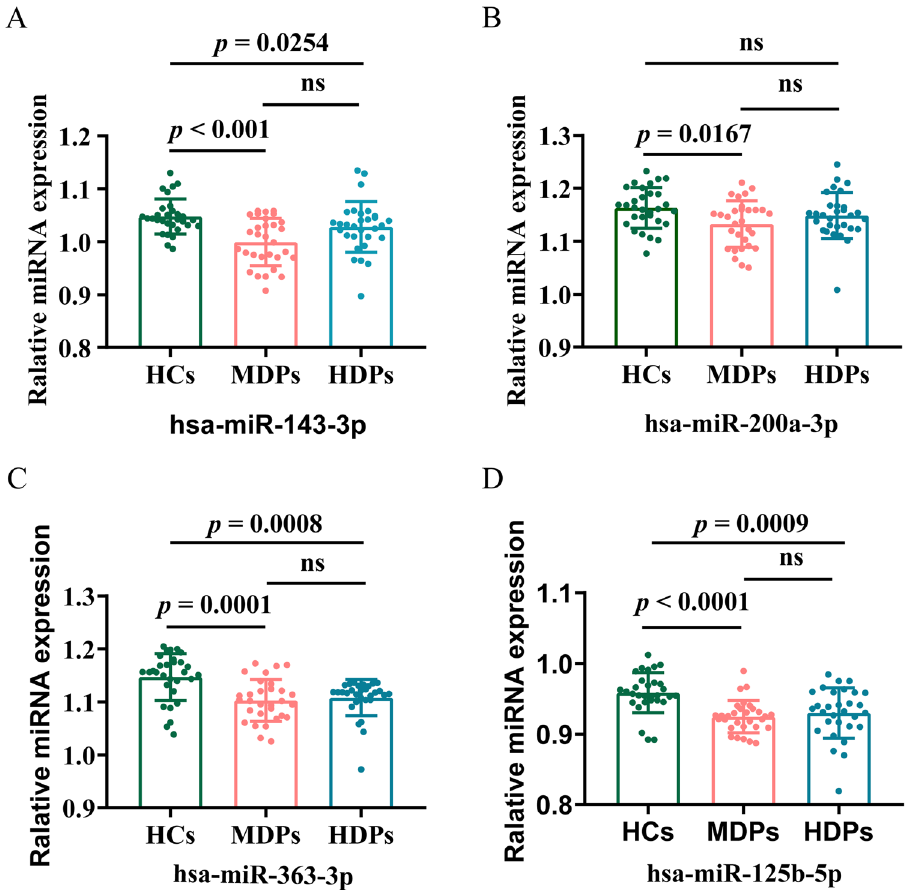
Figure 3. Expression level of 4 selected miRNAs assessed by real-time quantitative PCR. Relative expression level of miRNAs in the HCs, MDPs and HDPs groups, assessed by RT-qPCR; data are mean ± standard deviation (n = 30 in each group). ( A ) Relative expression level of hsa-miRNA-143-3p ( B ). Relative expression level of. ( C ). Relative expression level of hsa-miRNA-363-3p. ( D ). Relative expression level of hsa-miRNA-125-5p. MDPs Exosomes obtained from methamphetamine-dependent patients, HDPs Exosomes obtained from heroin- dependent patients, HCs Exosomes obtained from healthy